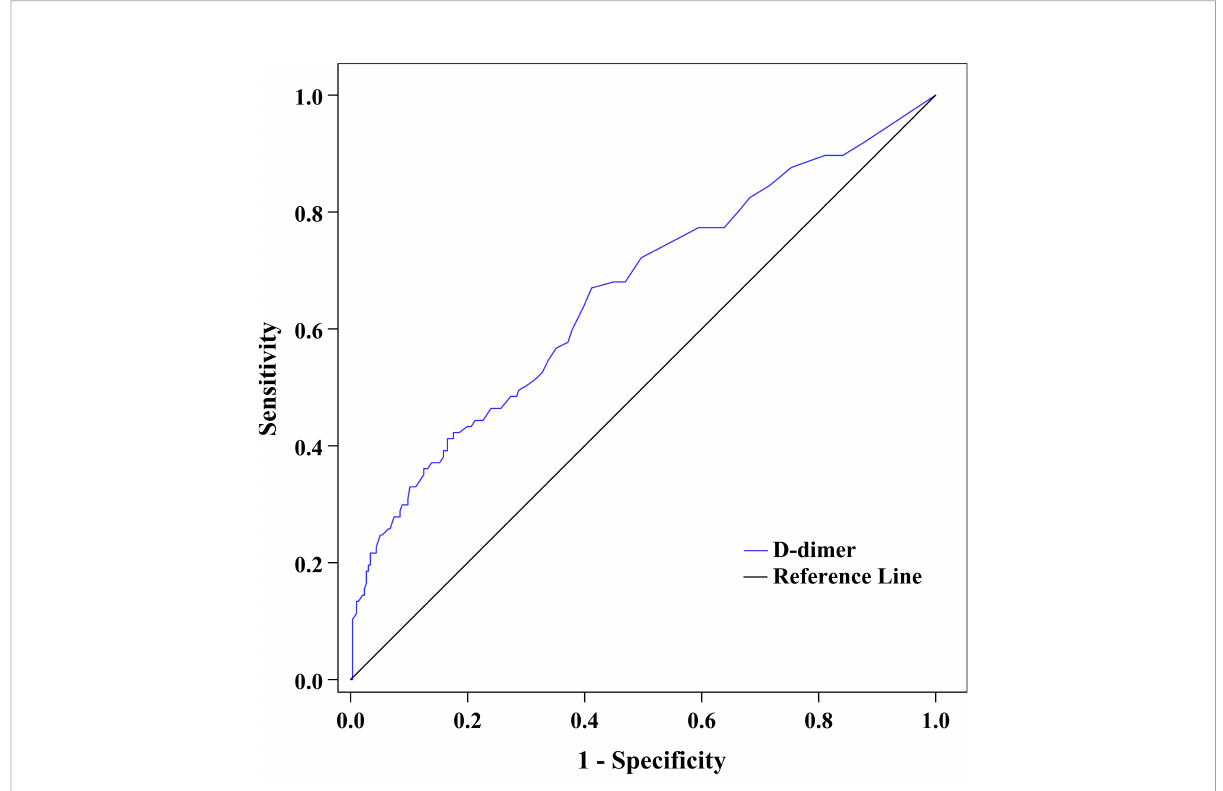
FIGURE 4 ROC curve exhibited the capability of plasma D-dimer to discriminate DPN (AUC was 0.659 [95% CI: 0.610 – 0.706], optimal cutoff value was ≥ 0.22 mg/L, Youden index was 0.26, sensitivity was 67.01%, and speci fi city was